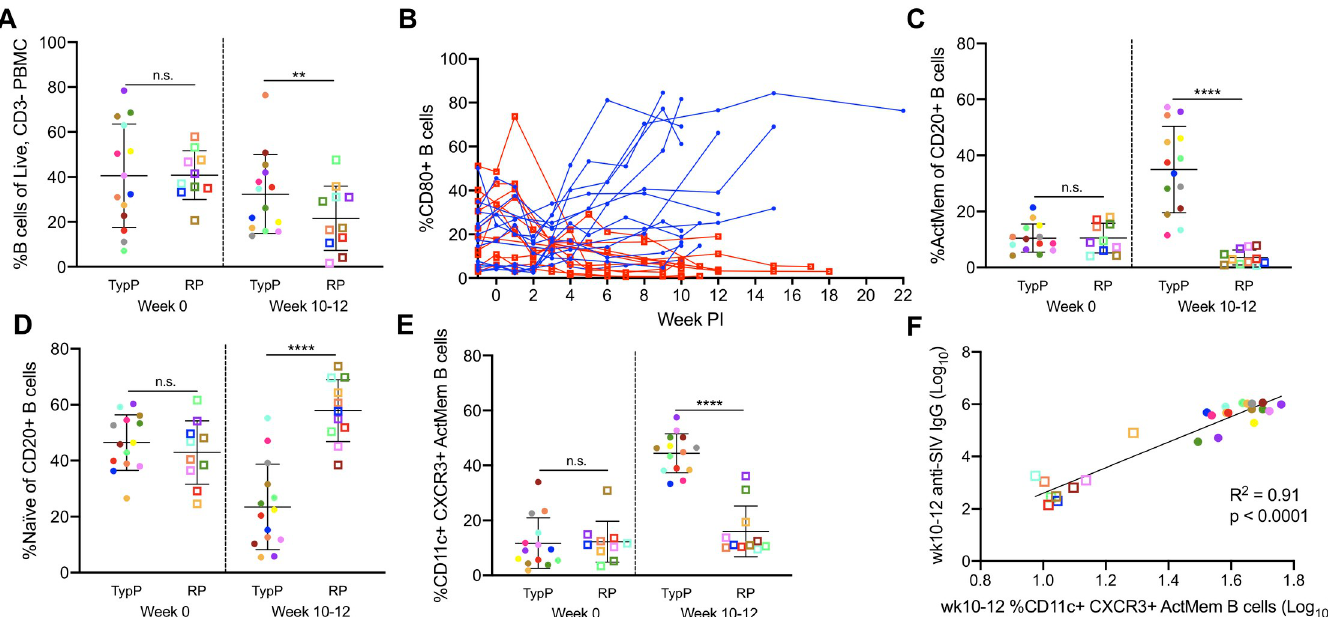
Fig 5. Rapidly progressing infants fail to increase activated memory B cells during chronic infection. Proportions of CD20+ B cells ( A ) as well as CD80+ activated B cells ( B ) are shown from PBMC of TypP ( closed circles, blue lines ) and RP ( open squares, red lines ) infants. Proportions of activated memory ( C ) and na ï ve ( D ) B cell populations from total CD20+ B cells are also compared between TypP and RP infants. Within activated memory B cells we compared atypical CD11c, CXCR3 double positive cells in both TypP and RP infants ( E ) and correlations with anti-SIV antibody levels are shown at week 10–12 ( F ). Statistical tests used to compare infant groups were carried out as described in the methods �� = p < 0.01, ��� = p < 0.001, ���� = p < 0.0001. Error bars are shown as either mean with standard deviation or median with interquartile range based on data distribution.